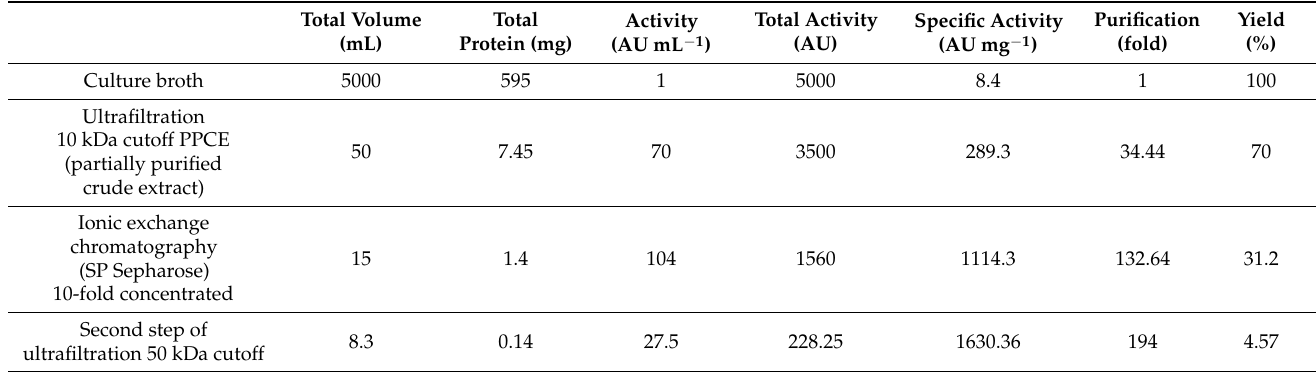
Table 2. Purification of WA18 from W. anomalus